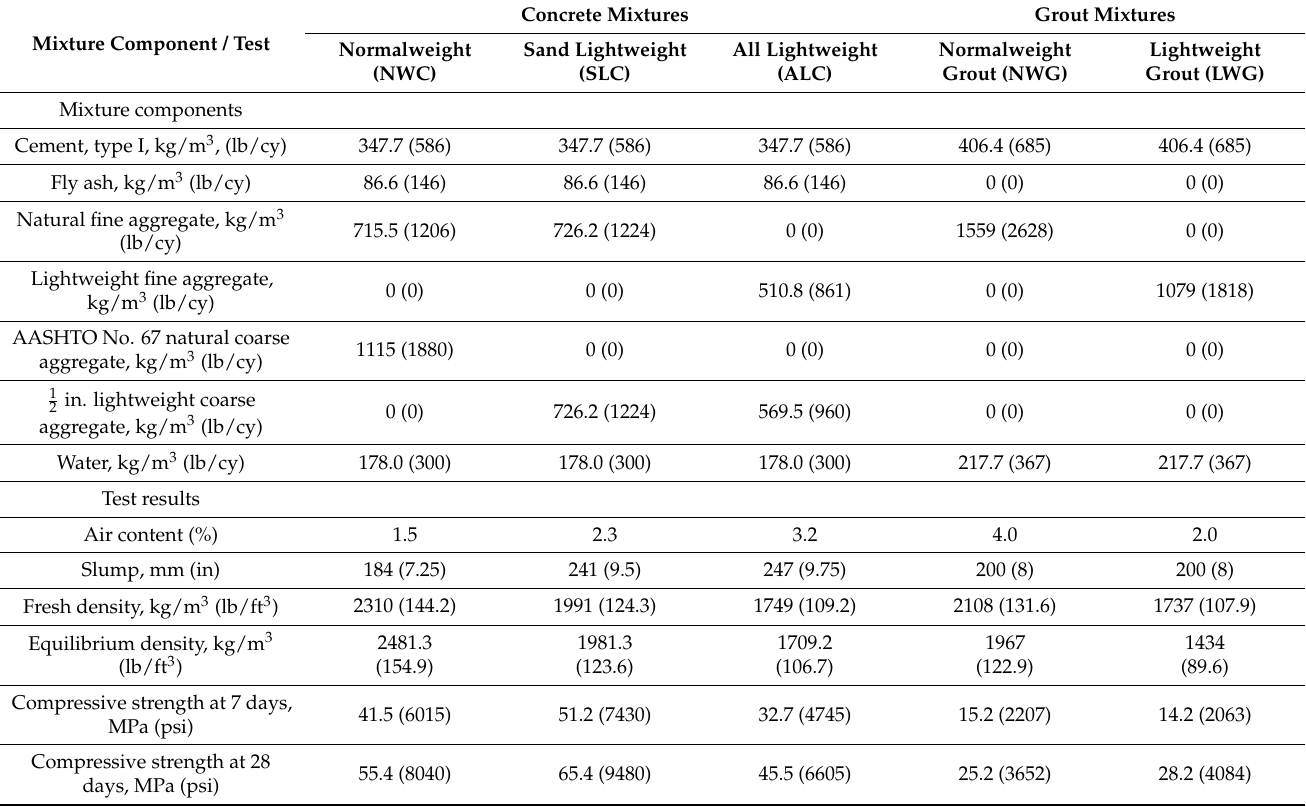
Table 2. Concrete and grout mixture proportions.